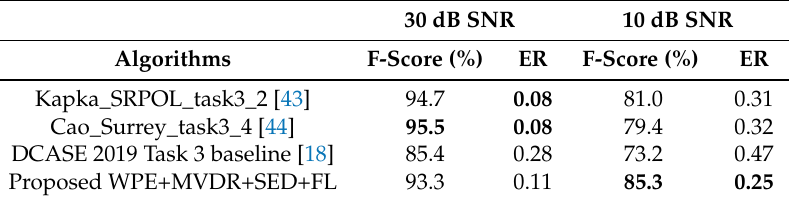
Table 7. F-score and ER results: evaluation